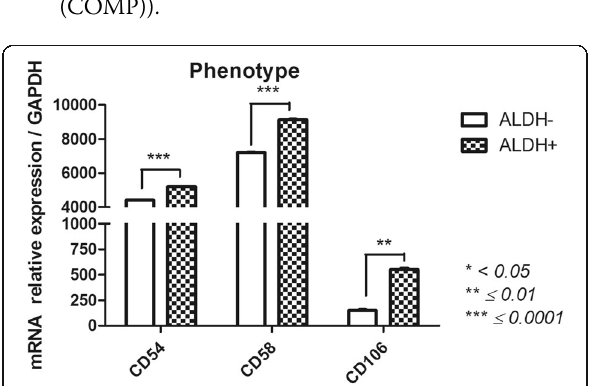
Fig. 6 Hypoxia-related gene expression profile of FSK-MSC subsets according to ALDH activity. After flow cytometry sorting of ALDH+ and ALDH- FSK-MSC subsets, we investigated by qPCR the expression profiles of hypoxia-associated genes HIF1 α , HIF2 α and GLUT1 . Data are presented as mean±SEM of mRNA gene expression relative to